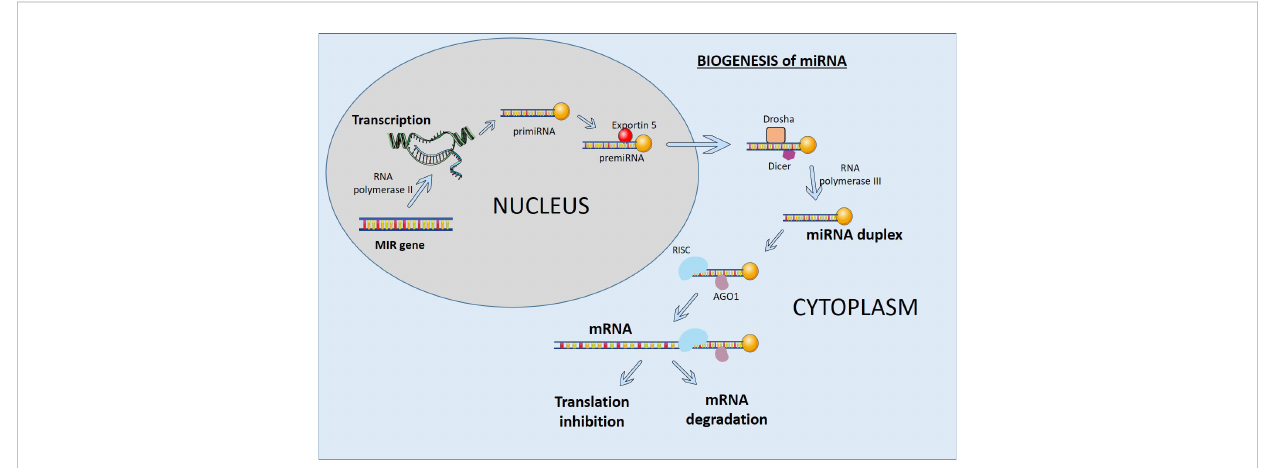
FIGURE 1 Mechanism of miRNA biogenesis and their functional